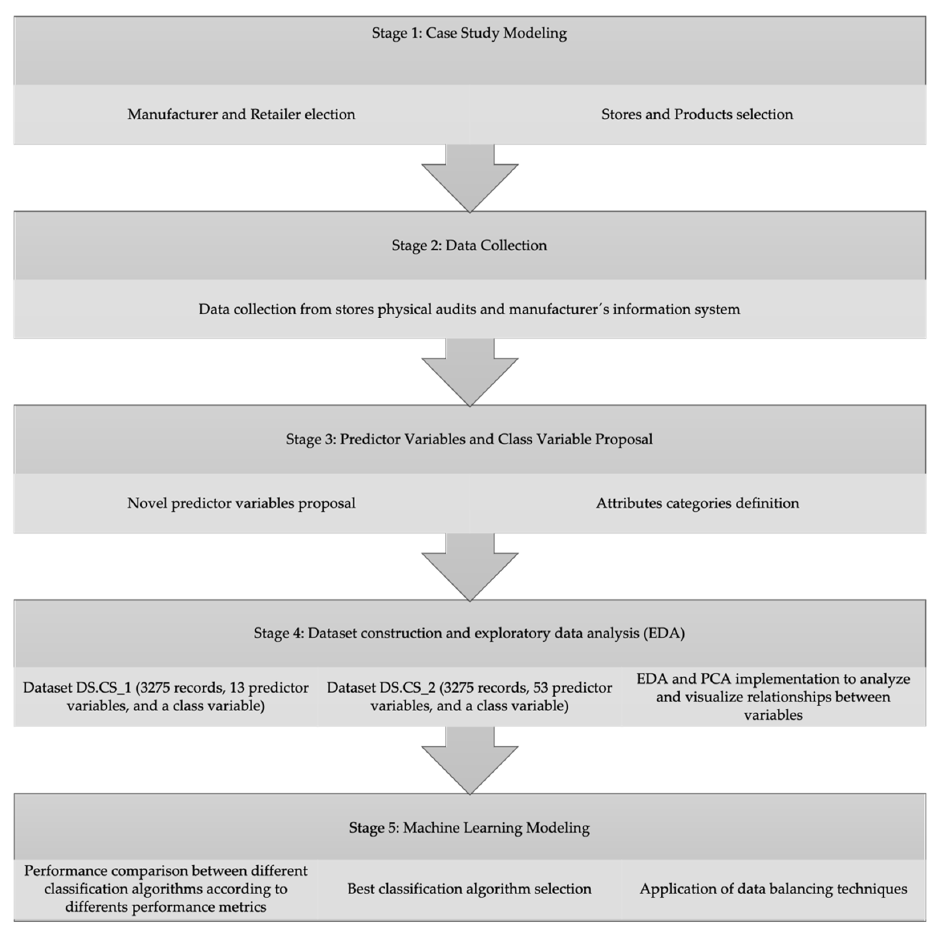
Figure 1. Methodological framework.